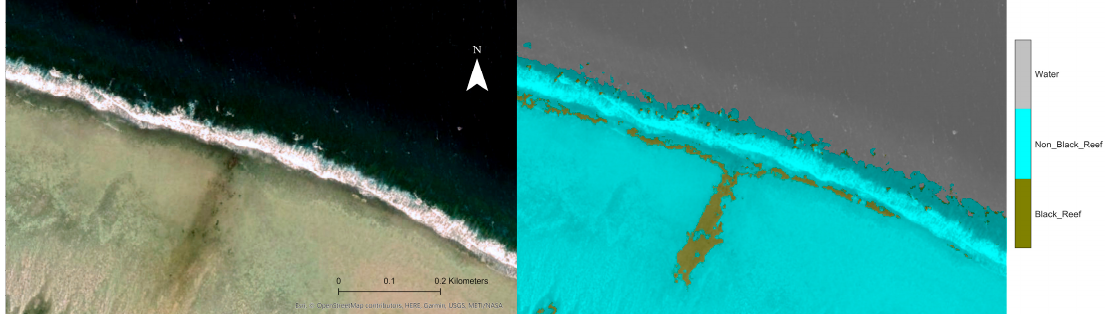
Figure 12. ( Left ) zoomed Google Earth imagery (Google Earth Pro, 2022) of the Kwajalein reef. ( Right ) corresponding segmented image.